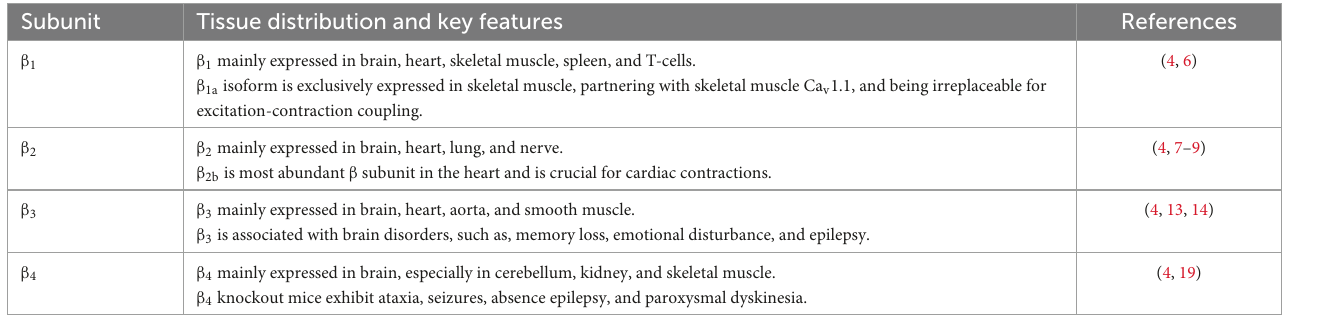
TABLE 1 Tissue distribution and key features of β